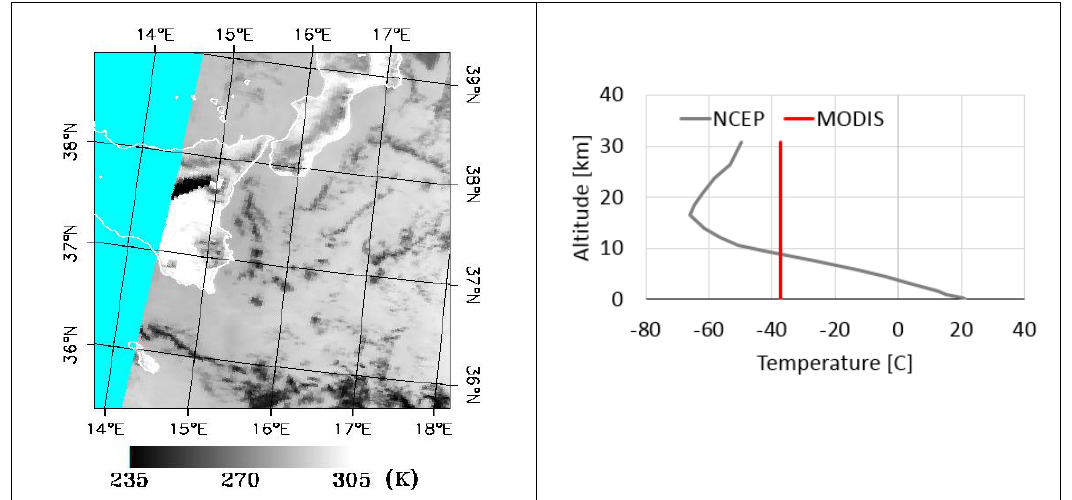
Figure 5. Left panel : brightness temperature at 11 µ m for the moderate resolution imaging spectroradiometer (MODIS)-Terra image collected the 26 October 2013 at 09:00 UTC. Right panel : National Centers for Environmental Prediction (NCEP) temperature profile (grey line) and dark pixel brightness temperature (red vertical line).